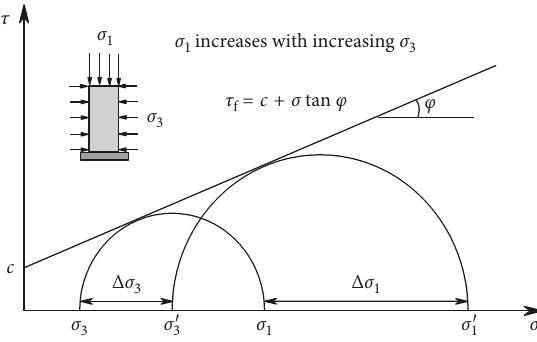
Figure 7: Effects of increasing σ